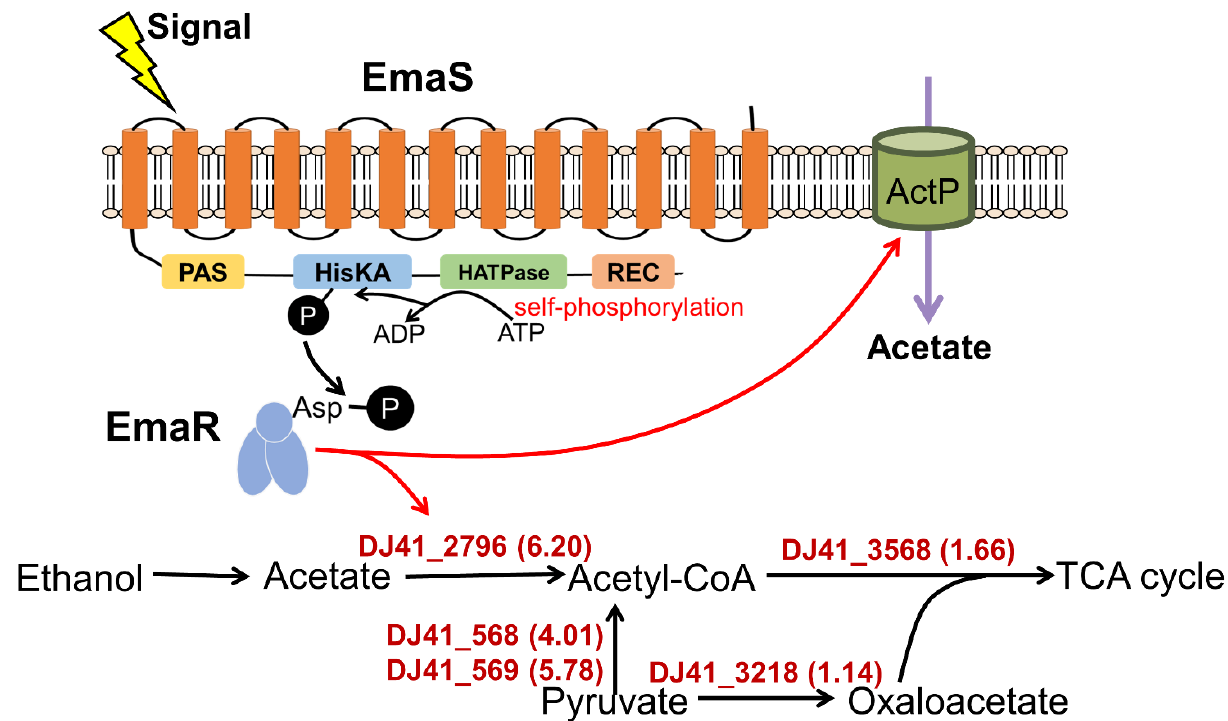
Figure 9. Schematic outlining the role of the EmaSR system in relation to the metabolic network of A. baumannii .